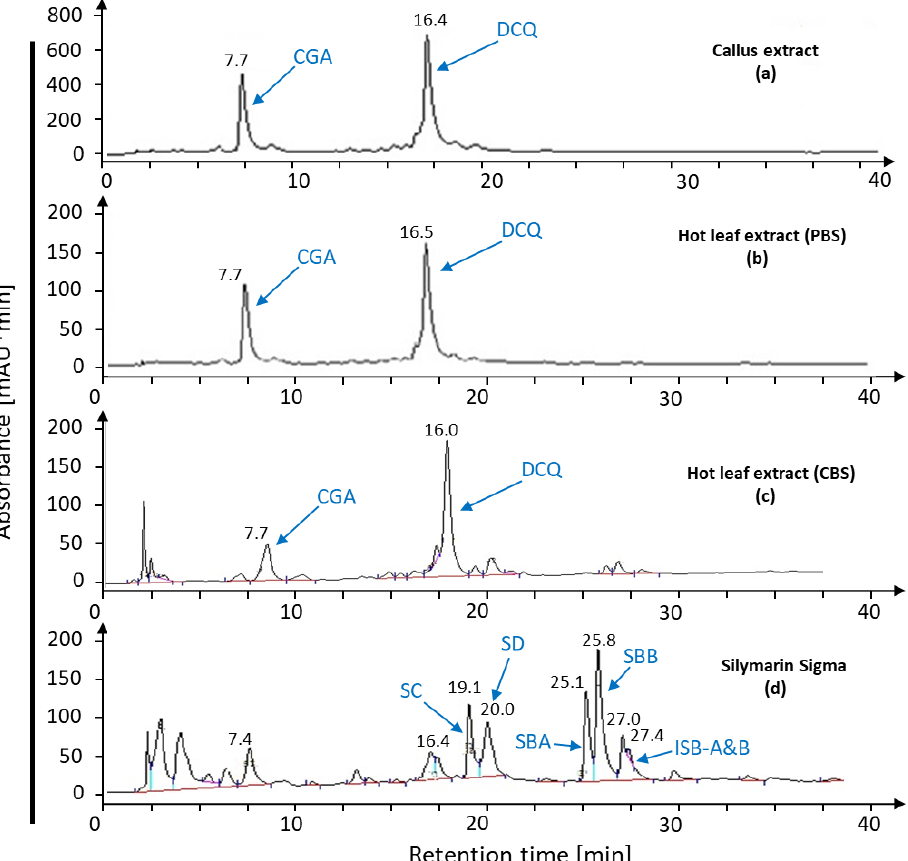
Figure 7. Bioconversion assay with hot leaf extract. Callus extract ( a ) was incubated with hot leaf extract prepared with citric acid buffer, pH = 4.6 ( c ), or phosphate buffer, pH 7.2 ( b ), on silymarin biosynthesis after incubation for 3 h. Profiles were compared with silymarin standard ( d ).